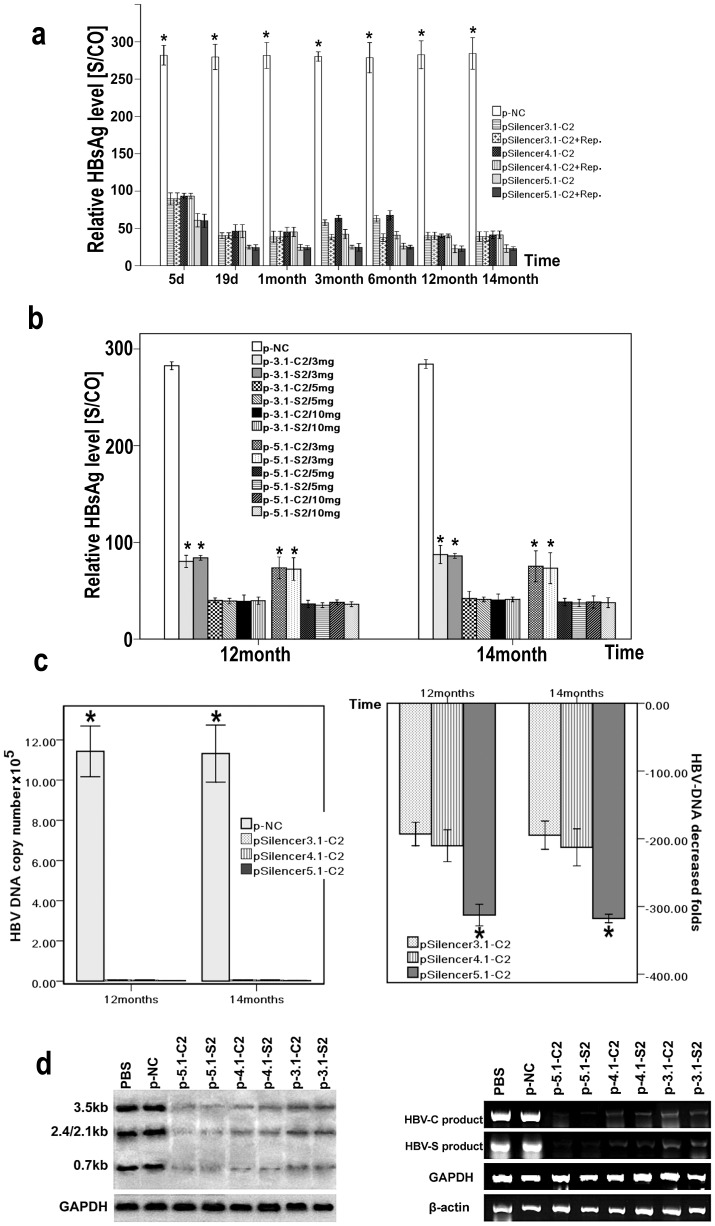
The silencing effect of specific siRNAs on HBV in transgenic mice.The HBsAg in mouse sera were quantitated by microparticle enzyme immunoassay (MEIA) at different time points post-tansfection (a). The silencing effects of siRNA on the HBsAg were compared among the different siRNA vector doses at 12- and 14-month post-ransfecion (b). The sample rate/cutoff rate (S/CO) values represent the relative amounts of HBsAg according to the AXSYM system. The long-term silencing effect of siRNA on the HBV-DNA in mouse sera was measured by real time fluorescent quantitative polymerase chain reaction (RT-qPCR) (c). Northern blot and reverse transcription PCR (RT-PCR) showed that HBV transcripts (3.5, 2.4/2.1 and 0.7 kb RNA) from the liver tissues of transgenic mice at 12-month post-transfection were substantially reduced by specific siRNAs (d). Housekeeping genes glyceraldehyde 3-phosphate dehydrogenase (GAPDH) and β-actin were used as internal controls. n = 6–8 mice per group. PBS, phosphate-buffered saline; p-NC, plasmid negative control; Rep., repeated injection; p-, pSilencer-. (*p<0.05).